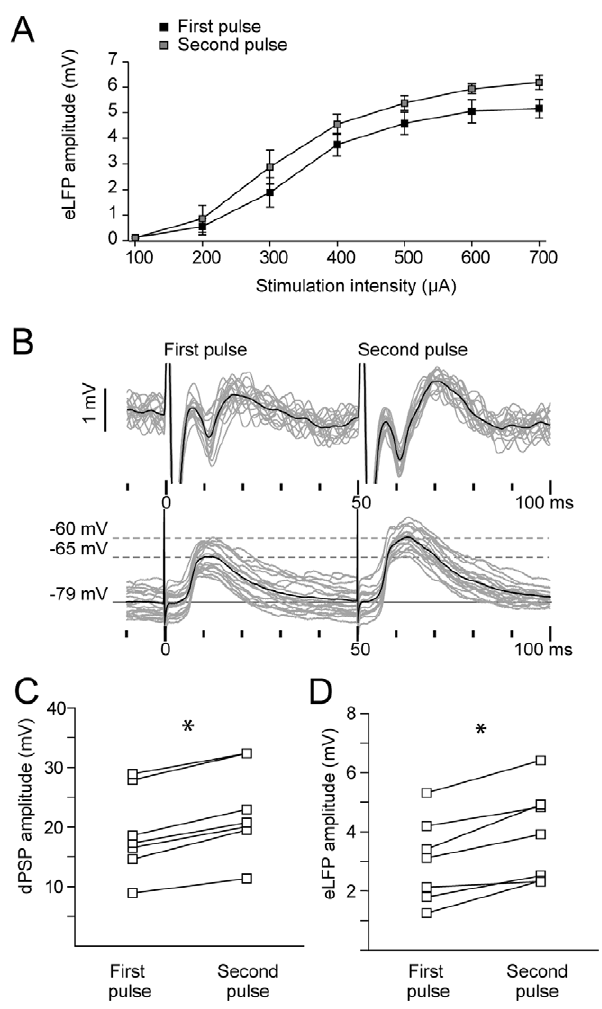
Figure 3. Evoked striatal field potentials show paired pulse facilitation. A. Amplitude of the striatal field response (mean 6 SEM, n=5) as a function of stimulation current intensity for cortical paired pulse stimulation (interstimulus interval 50 ms). B. Simultaneous recordings of striatal eLFP through a glass micropipette ( above ) and MSN membrane potential ( below ) after cortical paired pulse stimulation. C–D. Paired pulse stimulation at the prelimbic cortex (400 m A and 50 ms interstimulus interval) induces a facilitation of the response to the second stimulus in MSNs (C,* p , 0.0001, Student’s paired t test, n=7) andevoked striatal field potentials (D, * p , 0.005, Student’s paired t test, n=7).